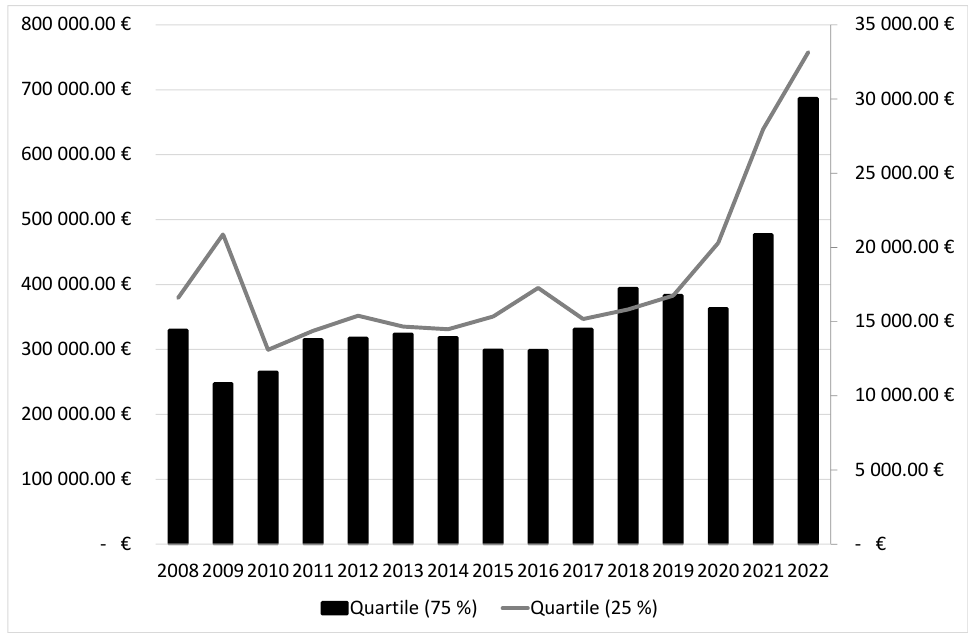
Figure 3. Absolute inventory amounts (in EUR) measured with upper quartile (75%) and lower quartile (25%) values within Finnish-stock-market-listed companies of manufacturing and trade during the period of 2008–2022 (the last year 2022 only consisted of data from first half of the year). The y-axis on the left-side is for upper quartile, and the y-axis on the right-side is for the lower quartile